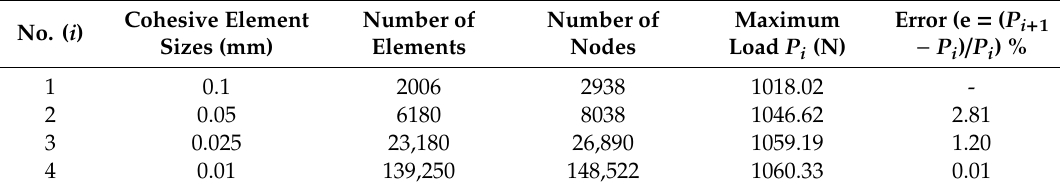
Figure 8. Load–displacement curve for di ff erent cohesive element mesh sizes. Figure 8. Load – displacement curve for different cohesive element mesh sizes. Table 4. Maximum loads and errors for di ff erent cohesive element Table 4. Maximum loads and errors for different cohesive element sizes.